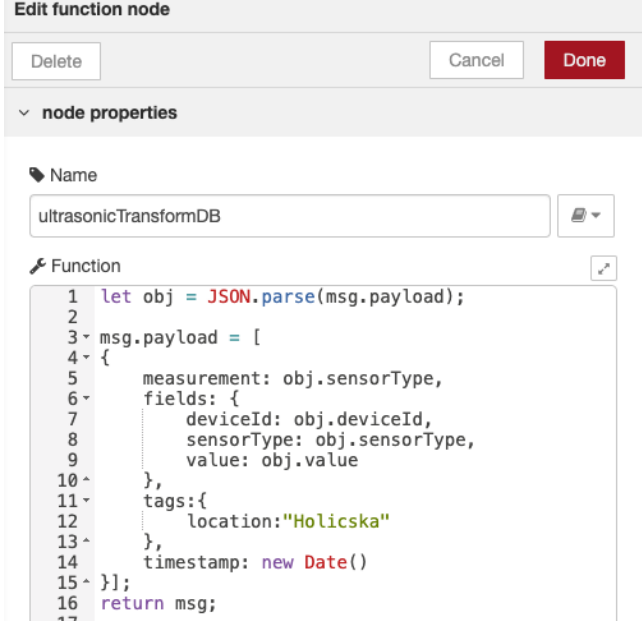
Figure 6. MQTT message transformation